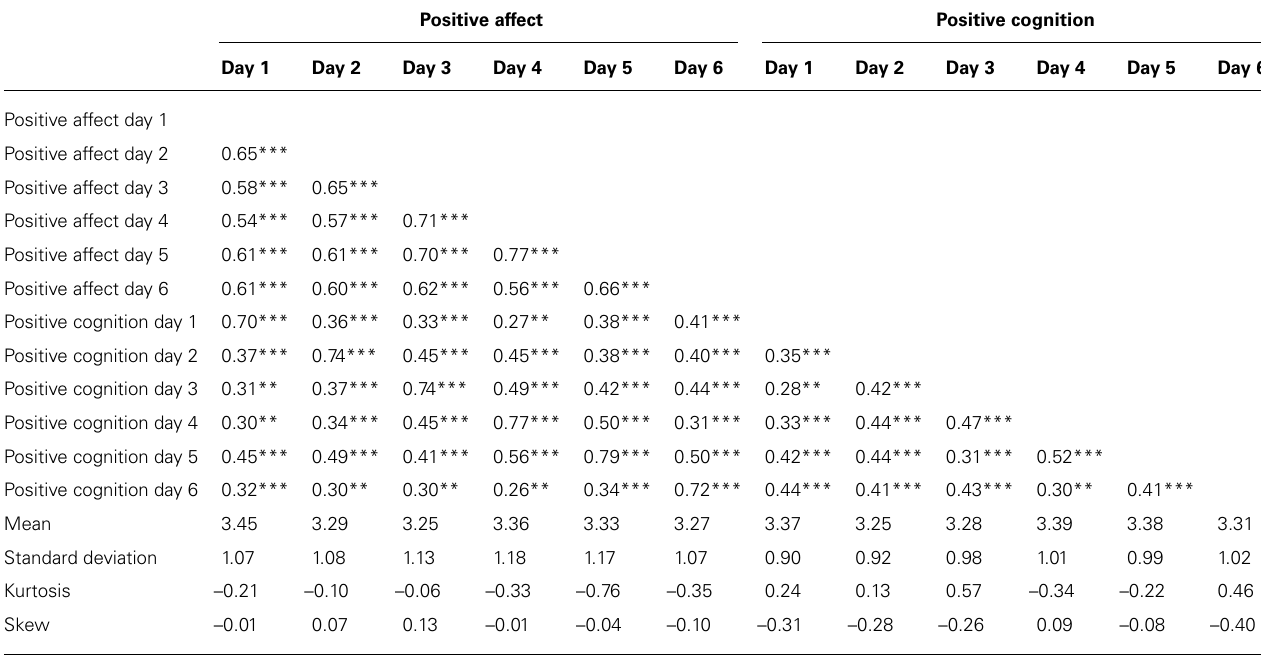
Table 1 | Correlations and univariate statistics of 6 days of positive affect and positive cognition following MBCT or a waitlist control condition.